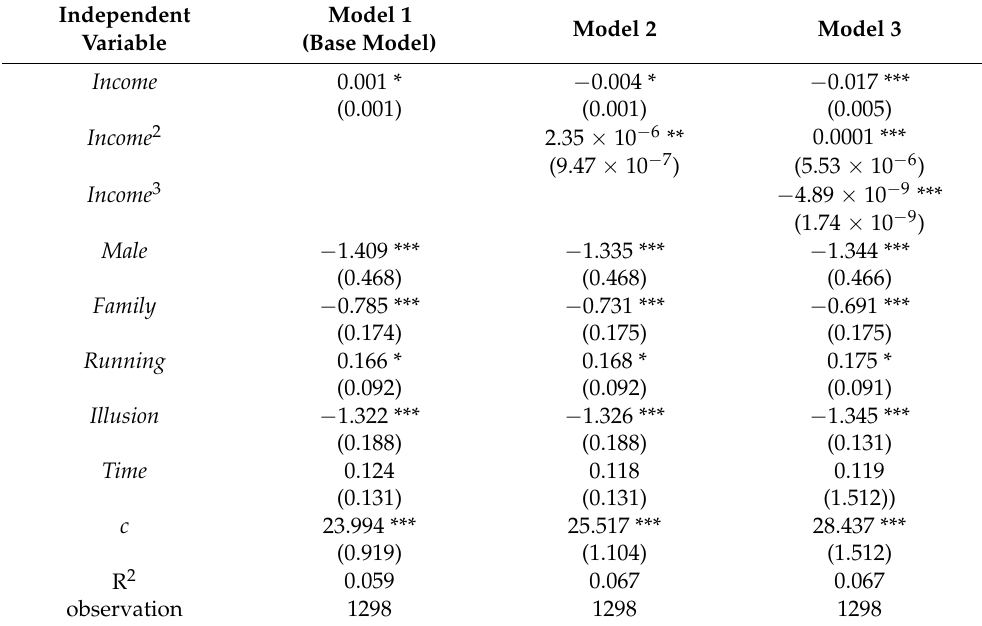
Table A1. Additional factor analysis of automotive vehicle’s